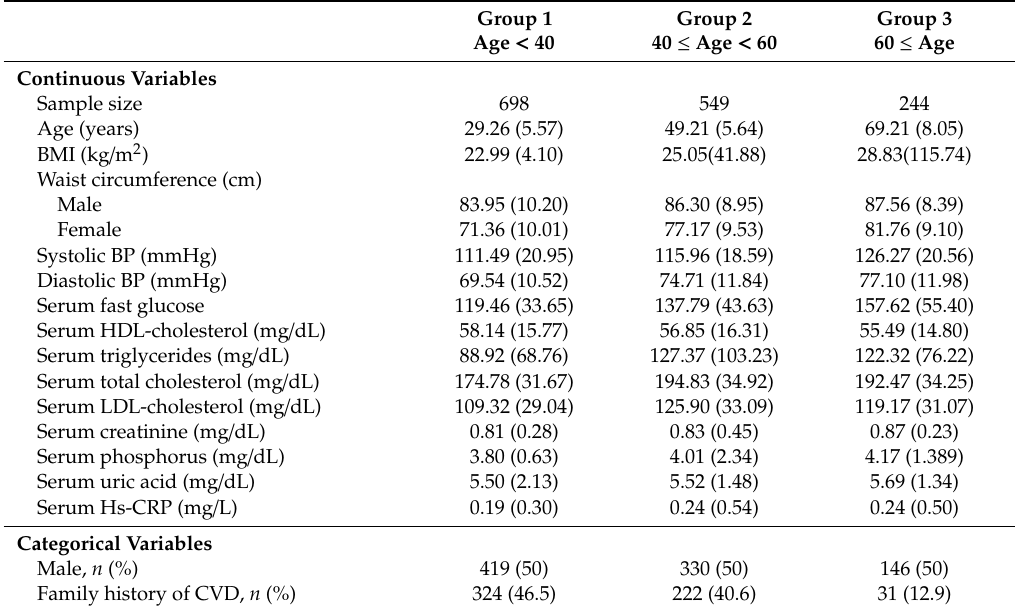
Table 1. Baseline demographic data.